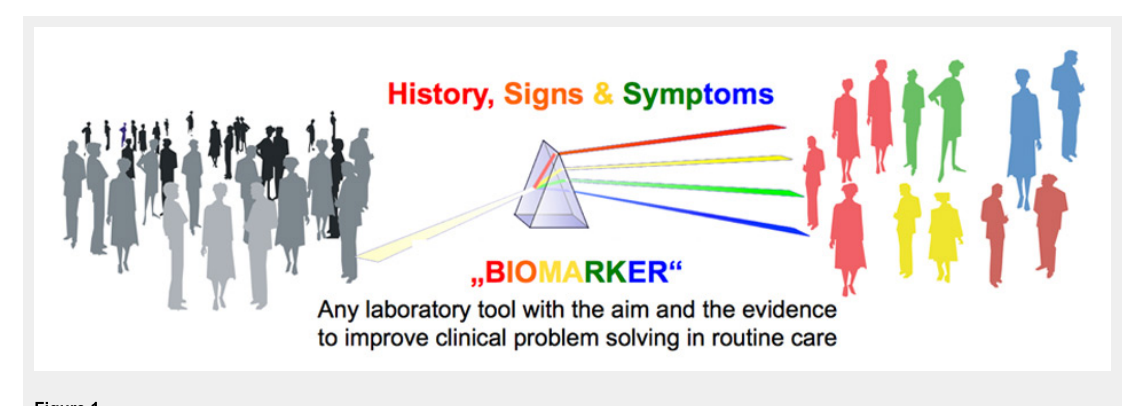
Combined clinical and biomarker assessment for a personalised emergency triage, therapeutic intervention and site of care decisions.